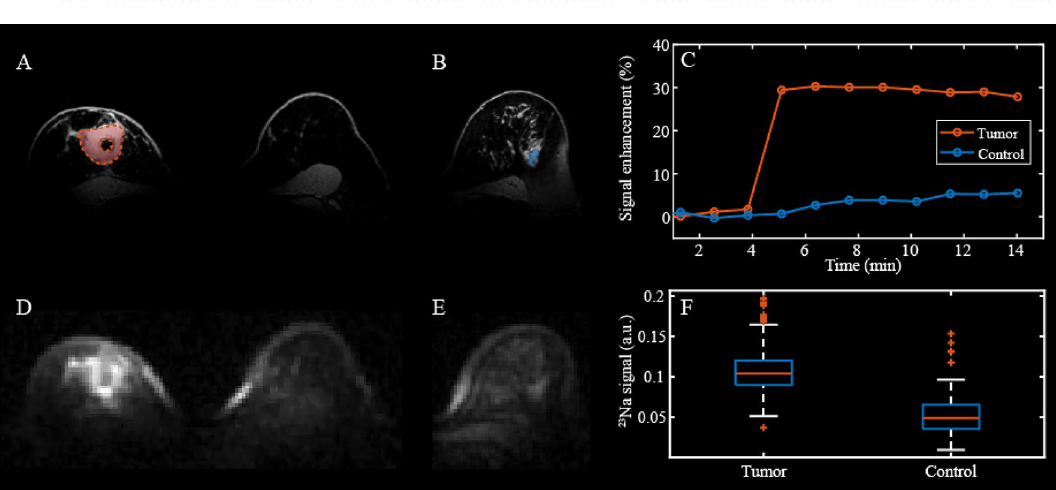
Figure 4. MRI images in 51-year-old patient with triple negative breast cancer. ( A ) Proton T 1 w fat suppressed (FS) anatomical image. The area in red is the ROI containing the lesion. ( B ) Different slice of the same volume showing the control ROI (blue region) in the contralateral breast. ( C ) Dynamic 1 H signal enhancement shows high uptake of contrast agent (CA) in a 645-voxel-ROI that includes the tumor (red ROI in panel A) compared to a 100-voxel control ROI in contralateral healthy fibroglandular tissue (blue region in panel B ) ( D ) Sodium image, corresponding to the 1 H T 1 w in panel A, acquired with a FLORET sequence showing hyperintensity in the tumor. ( E ) Sodium image in which healthy contralateral tissue is visible, co-registered with the 1 H T 1 w image in ( B ). ( F ) Boxplot showing the distribution of 23 Na signal within the tumor and in the contralateral healthy fibroglandular tissue (control). Sodium signal intensity in the lesion is 2-fold higher than in the